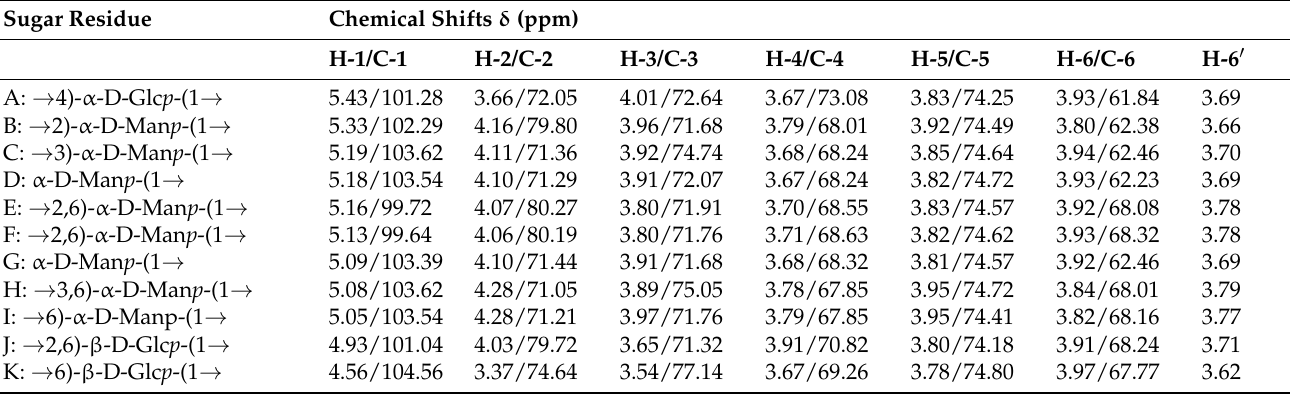
Table 3. 1 H and 13 C NMR chemical shift data for